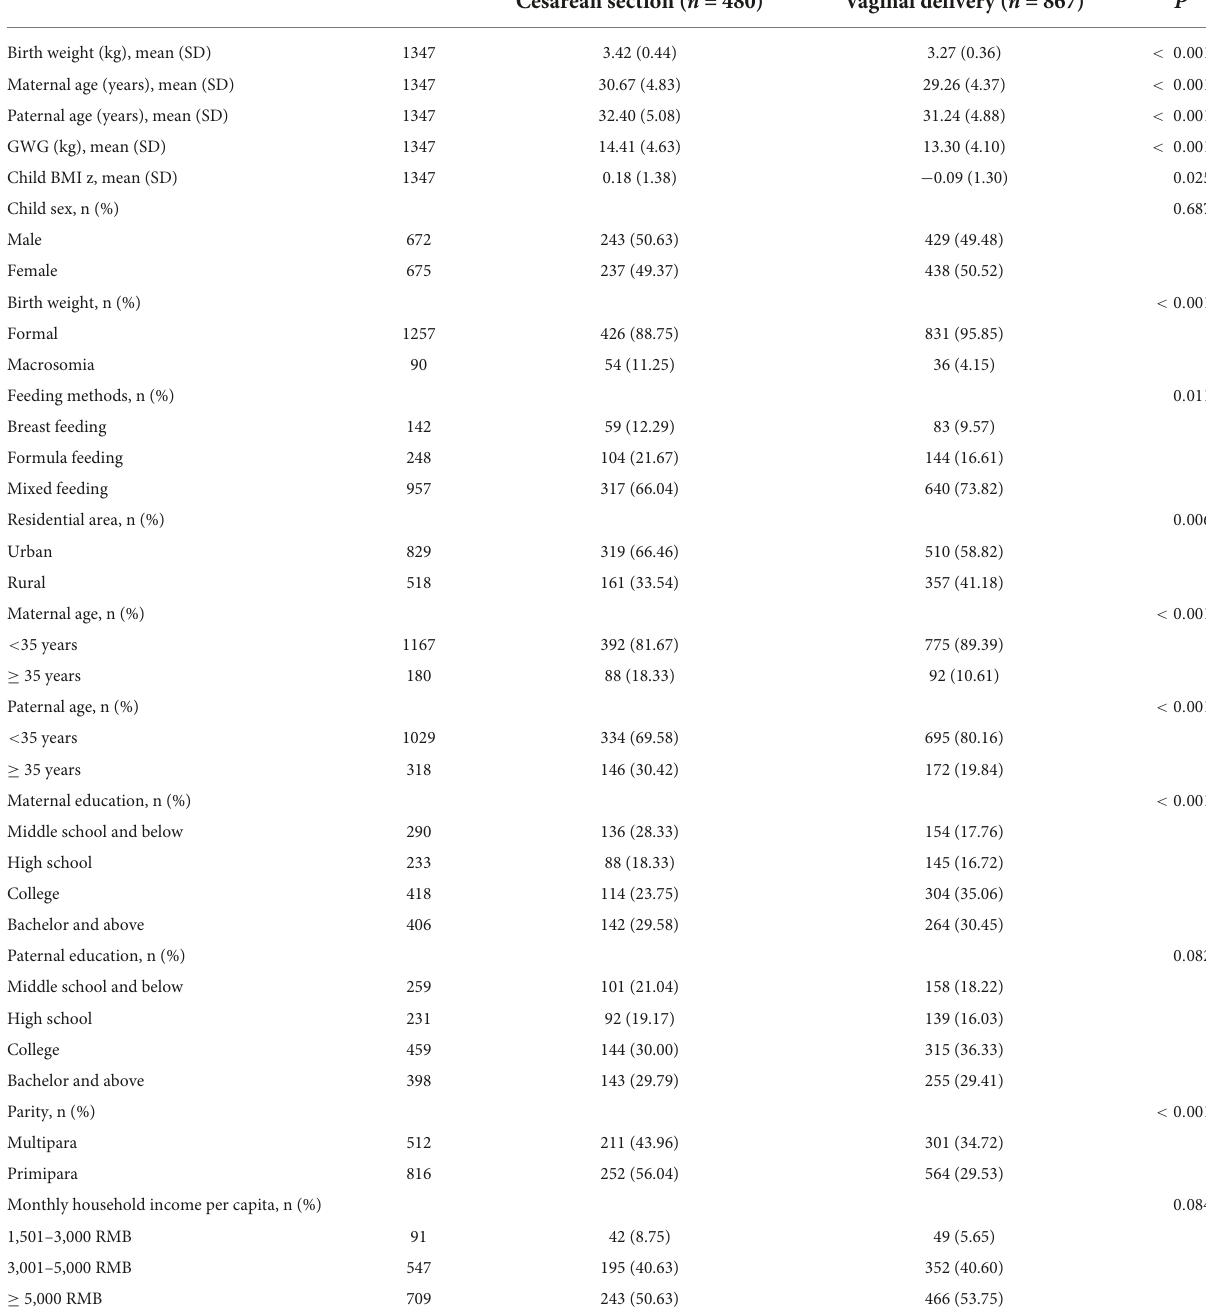
TABLE 1 Characteristics of the study population by delivery mode ( n =